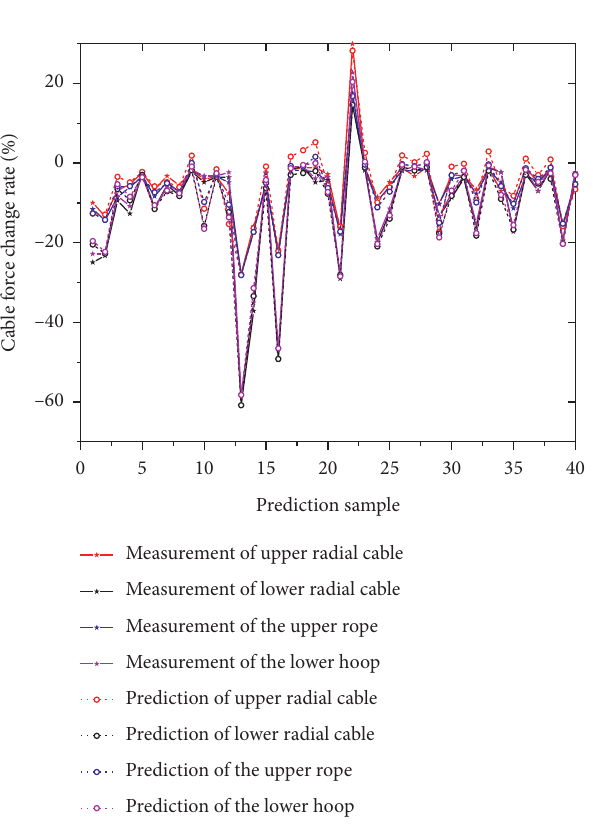
Figure 14: Comparison of prediction results of cable force change rate in the training Figure 17. With the continuous loading of the structure, the cable force value and deflection value of the lower radial